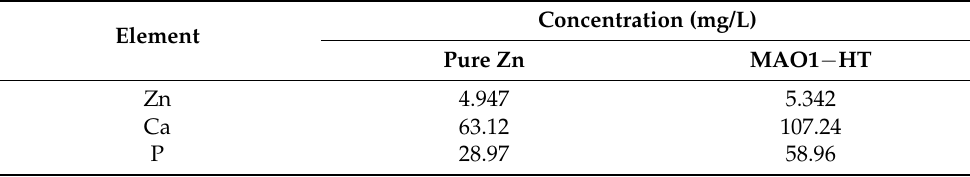
Figure 7. Morphologies of cells in different concentration of extract culture solution. ( a – c ) MAO1−HT and ( d – f ) pure Zn. Table 4. ICP-OES results of elements in pure Zn and MAO1 − HT cell culture solution. Table 4. ICP-OES results of elements in pure Zn and MAO1−HT cell culture solution.